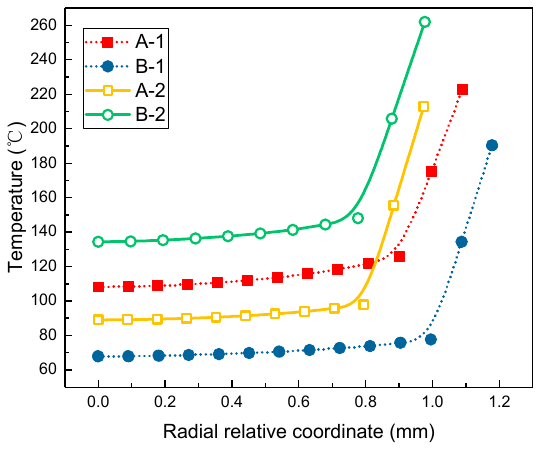
Figure 7. Radial variation of temperature in wires.